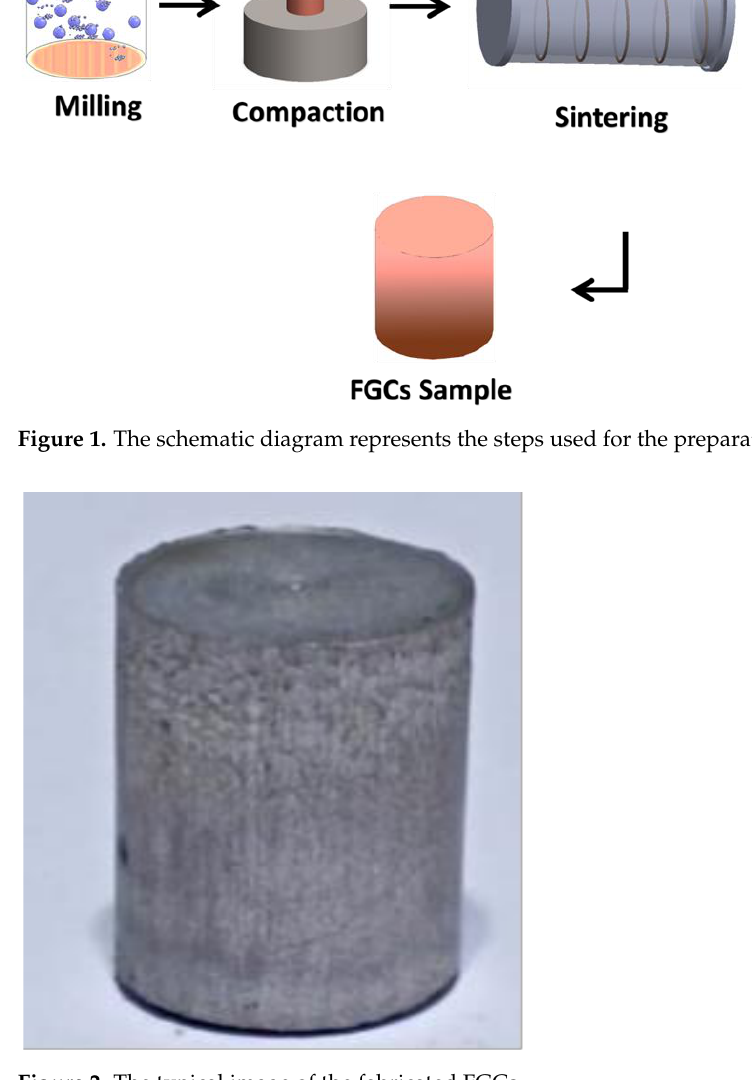
Figure 2. The typical image of the fabricated FGCs.